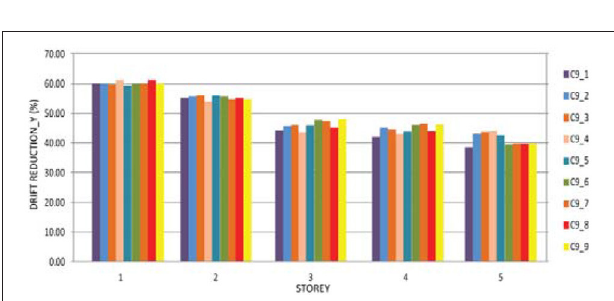
FIGURE 18 | Reduction of the inter story drifts in the case of the structure with the optimal solutions from the ninth cycle compared with the structure without dampers in Y